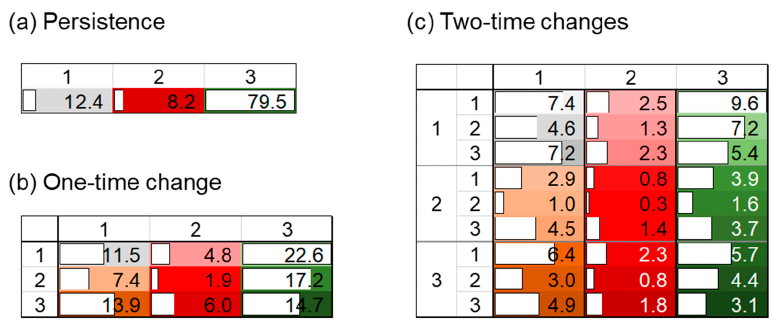
Figure 5. Matrix for the process of the urban vegetation dynamics. ( a ) persistent change, ( b ) process with one-time change, and ( c ) process with two-time changes. The values in the matrices represent the area proportion.